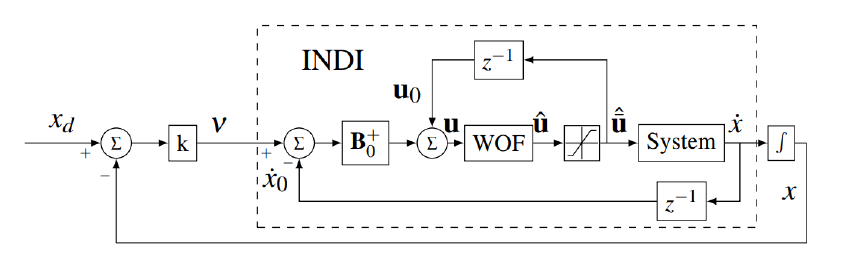
Figure 8. Numerical Example: Block diagram of the closed loop system of INDI+WOF.